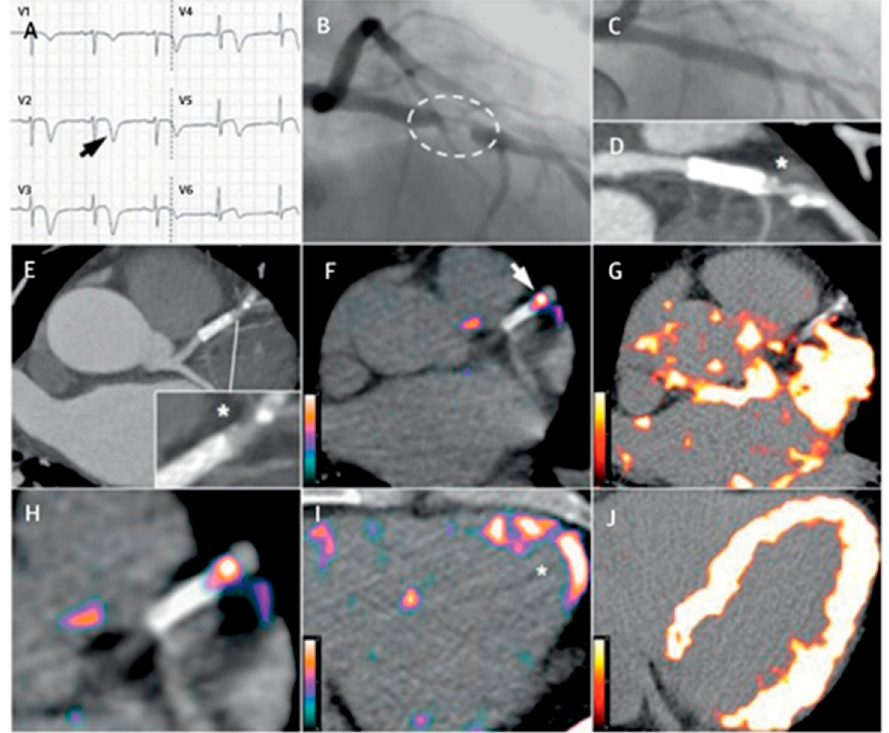
Figure 2. Comparison between 68 Ga-DOTATATE and 18 F FDG. Culprit left anterior descending (LAD) coronary artery stenosis in a 57-year-old man with acute coronary syndrome. ( A ) ECG showing ST-T segment elevation and inverted deep T-waves in V2-V5. ( B ) Angiography detected severe obstructive LAD lesion. After percutaneous coronary stenting, residual coronary plaque is seen with low attenuation and spotty calcification ( C – E ; star symbol depicts location of residual lesion). 68 Ga-DOTA-TATE PET shows intense focal uptake, consistent with inflammation of high-risk atherosclerotic plaques in the distal portion of the stented culprit lesion ( F , H , I ). 18 F-FDG PET ( G , J ) shows myocardial spillover, completely obscuring the coronary arteries. Adapted with permission from ref.